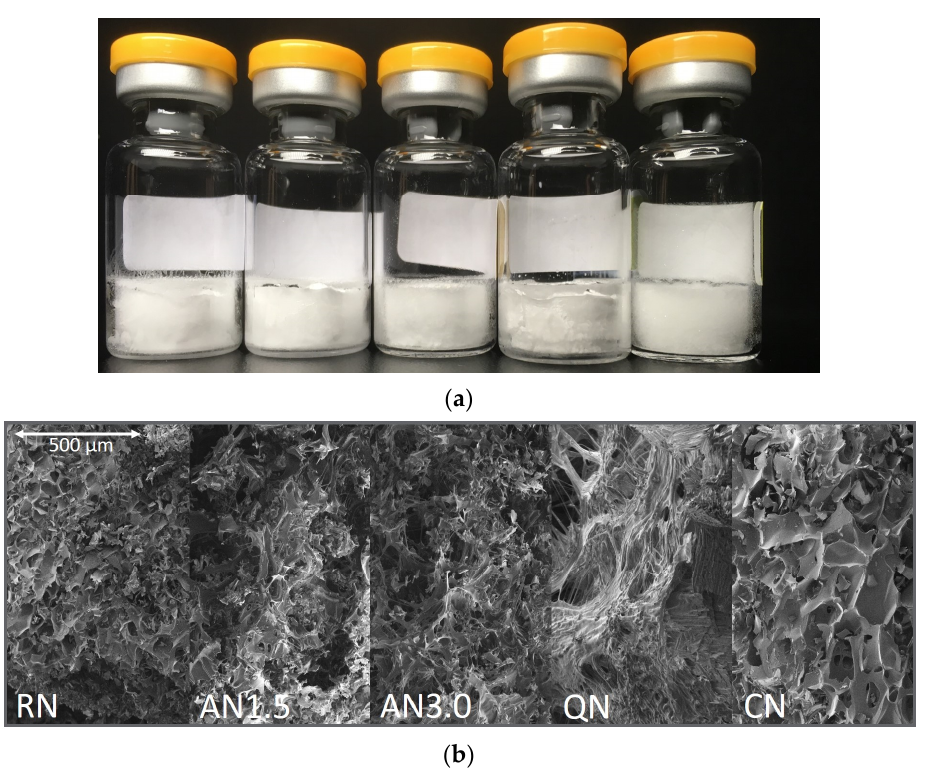
Figure 2. Representative optical appearance of 2 mg/mL_1.6PS_Suc samples: ( a ) macroscopic appearance and ( b ) scanning electron microscopy. Processes from left to right: RN, random nucleation; AN1.5, additional annealing step of 1.5 h; AN3.0, additional annealing step of 3.0 h; CN, controlled nucleation; QN, quench cooling.